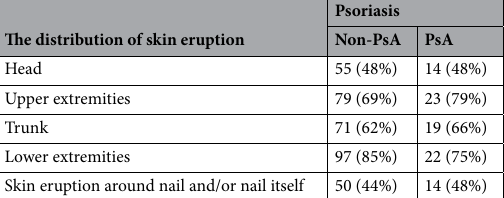
The distribution of skin